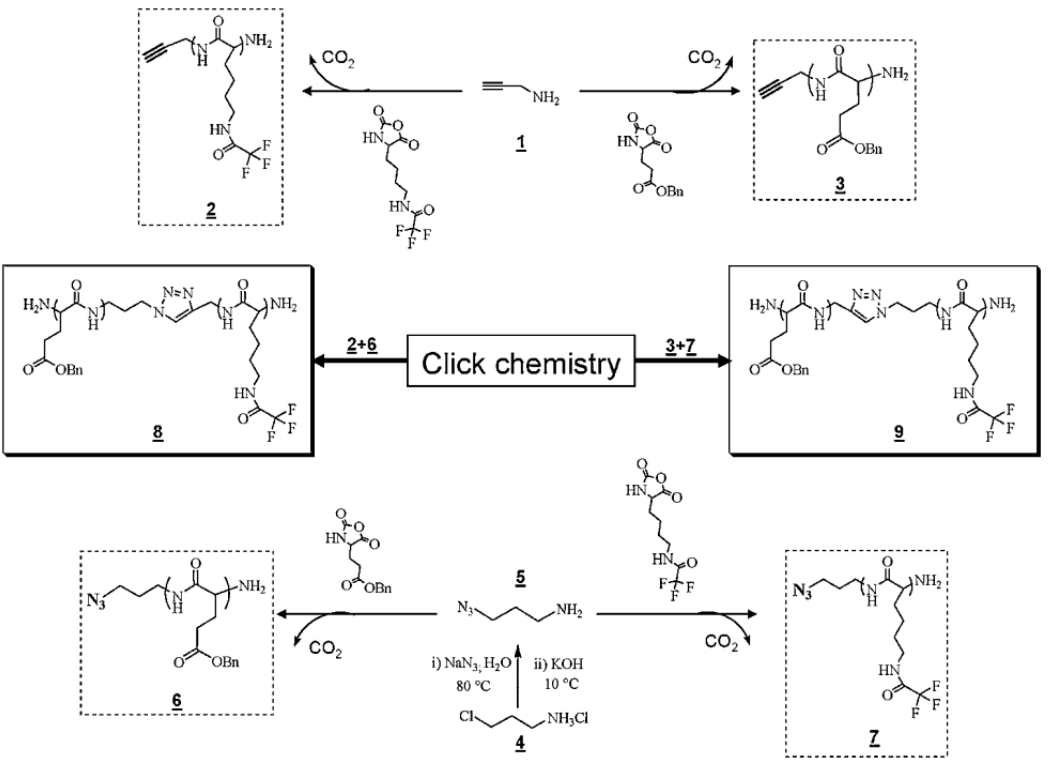
Figure 28. Synthesis of PBLGlu- b -PTFALys diblock copolymers by click chemistry as reported by Agut et al. [125].